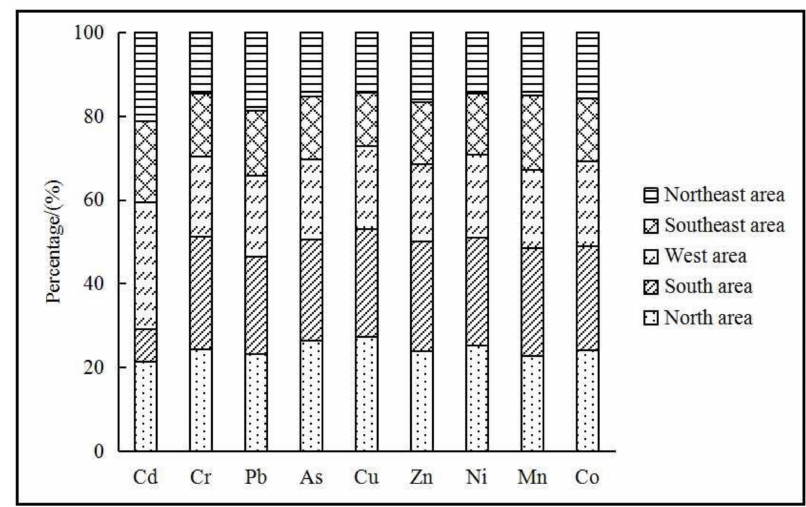
Figure 2. Spatial distribution of the proportions of heavy metals in the surface soil around Qinghai Lake.